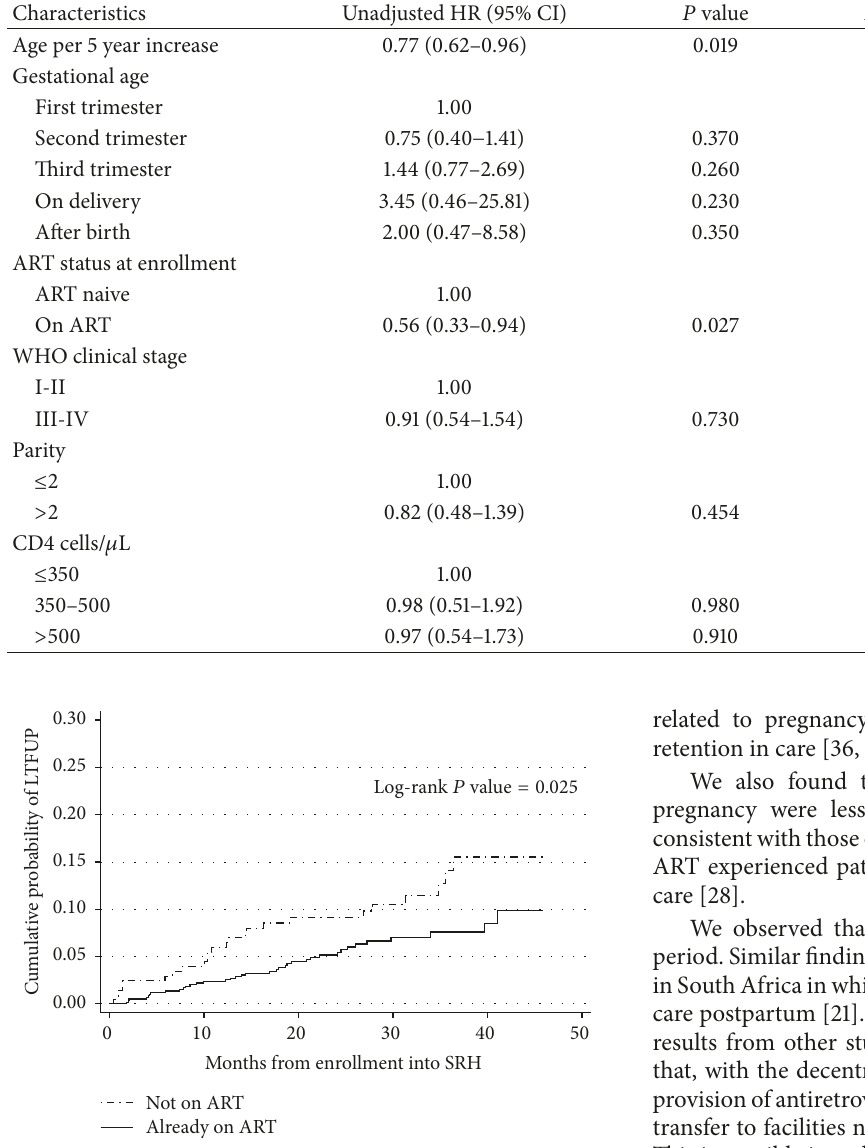
Figure 2: Showing cumulative probability of being lost to program by ART